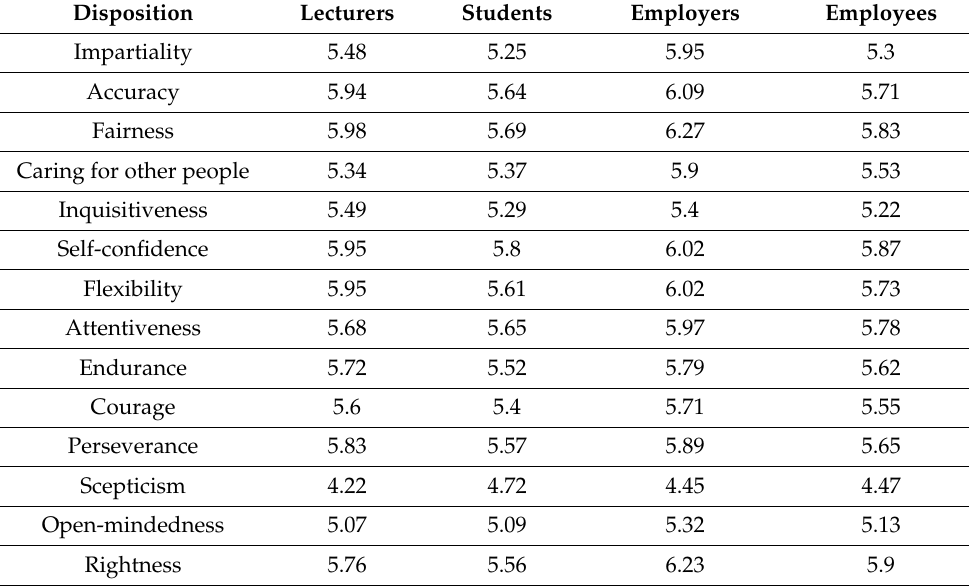
Table 7. Evaluation of the importance of critical thinking dispositions in the modern labour market (arithmetic mean (M), where 1 is ‘not important at all’ and 7 is ‘very